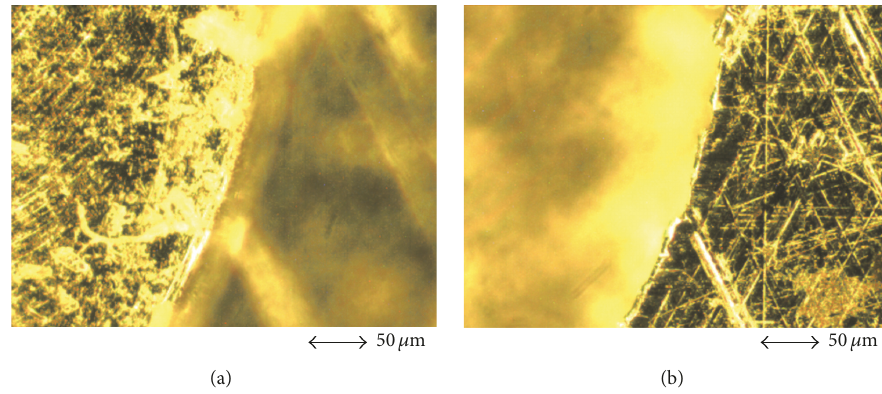
Figure 5: Microscope images after the experiment, T100. (a) Focus on the bottom part of the texture, wear particles trapped. (b) Focus on the plateau; this image shows the expected wear on the texturing boundary; however, no significant wear is detected on the neighbouring plateau.